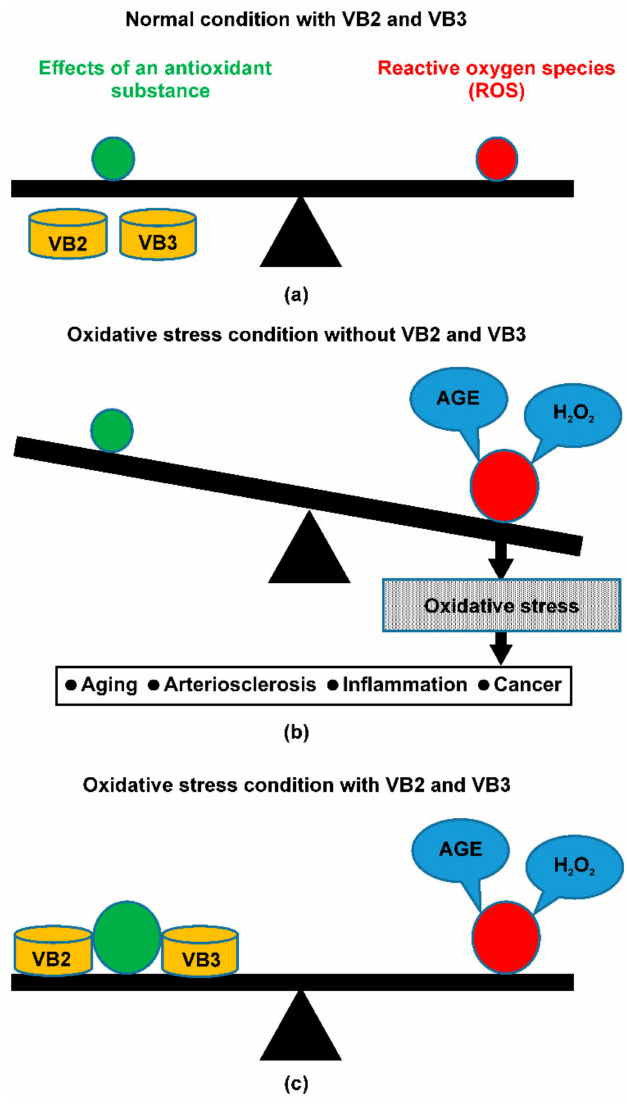
Figure 8. Importance of the balance between oxidative stress and antioxidant effects. There is little effect on the cells when VBs are applied in a stress-free condition ( a ). On the other hand, under AGE- and H 2 O 2 -induced stress conditions, intracellular ROS production is increased. Such oxidative stress can lead to aging, atherosclerosis, inflammation, and cancer ( b ). However, in such a stressful environment, VBs induce the expression of molecules that exert cytoprotective effects and suppress ROS production ( c